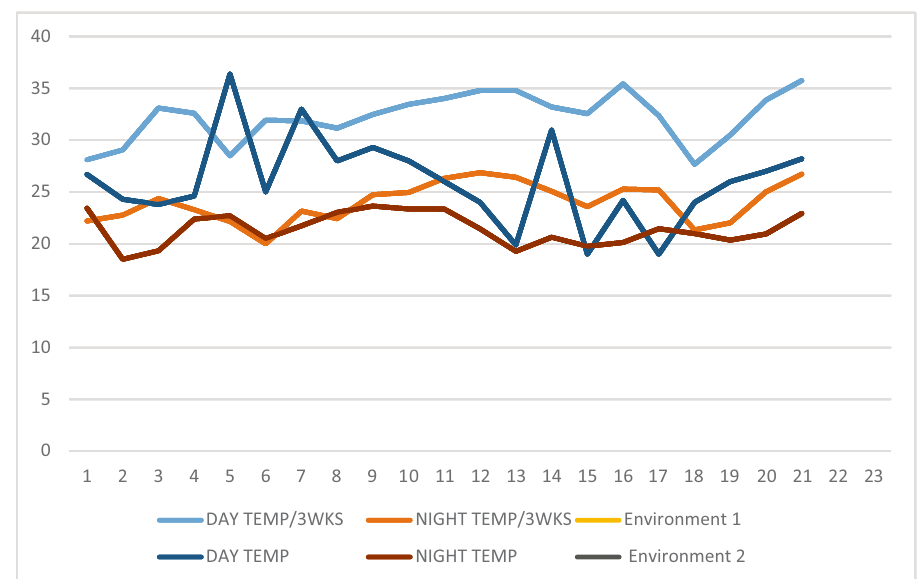
Figure 3: Graph showing day and night temperature ranges for 3 weeks.